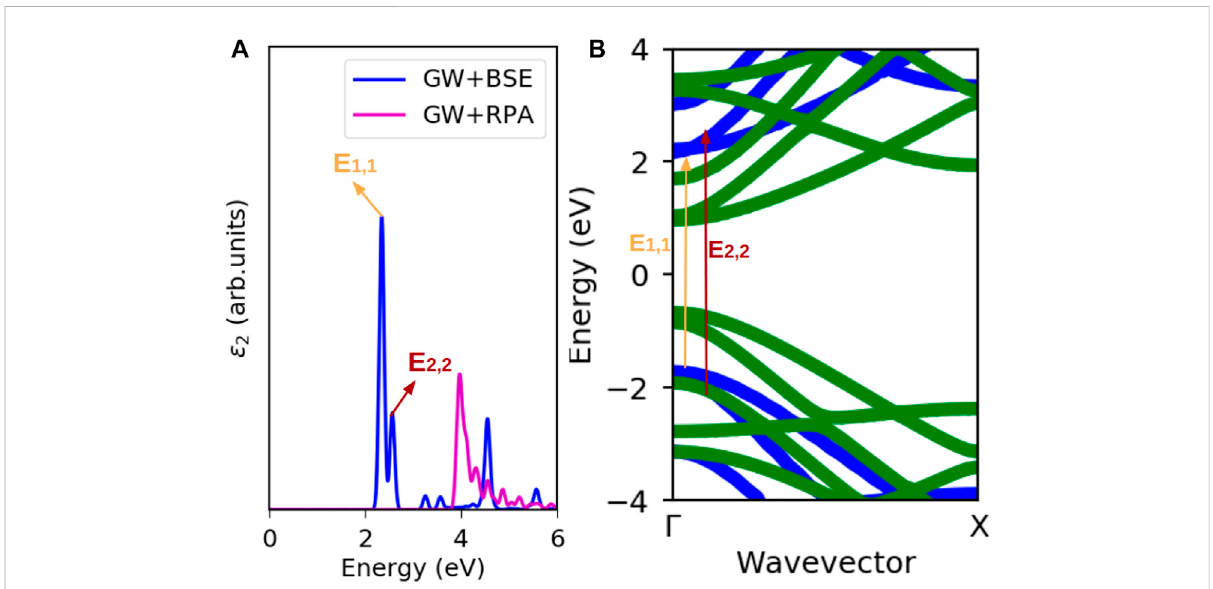
FIGURE 5 Excitationsina7-AGNR. (A) Absorptionspectraof7-AGNR. (B) GWbandstructureof7-AGNR. E 1,1 istheexcitationfromhighestvalencebandto lowest conduction band and E 2,2 is the excitation from second highest valence band to second lowest conduction band.